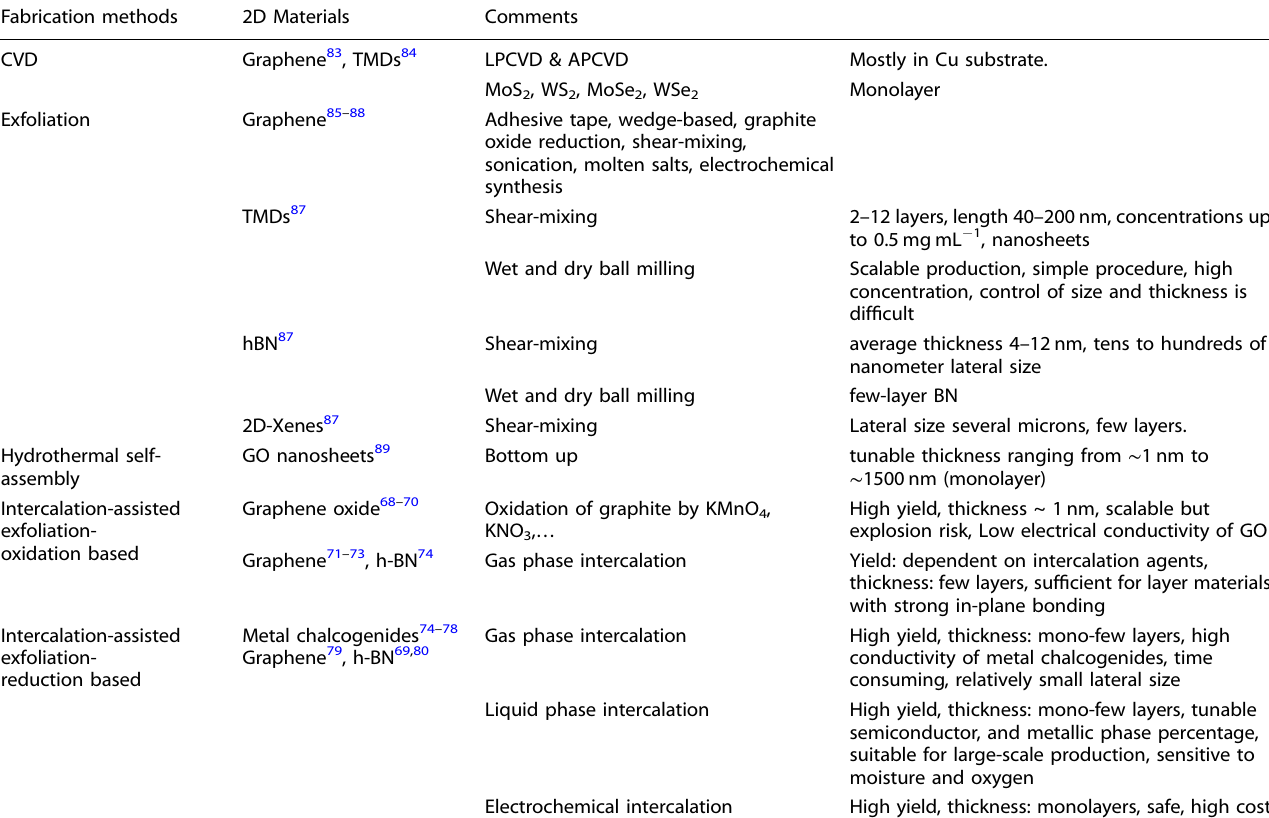
Table 1. Summary of different fabrication methods for various layered vdW materials and their properties. Fabrication